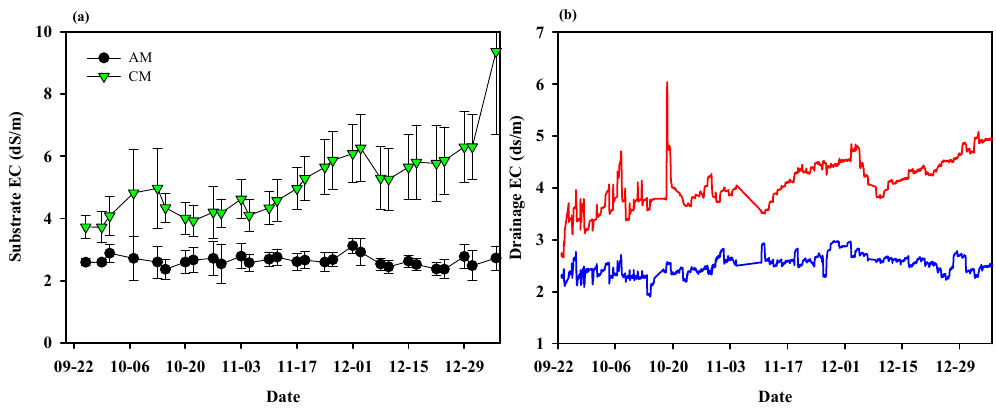
Figure 4. Comparison of electrical conductivity (mean ± SD ) in the rockwool substrate ( a ) and the drainage ( b ) of the closed-loop soilless culture system during the experimental period between conventional (CM) and alternative (AM) nutrient-replenishment methods.